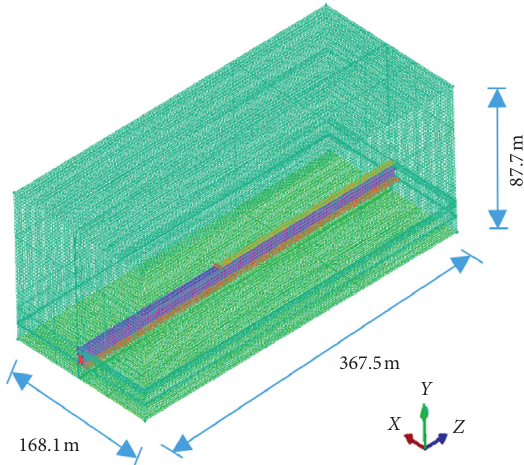
Figure 4: Model of high-speed